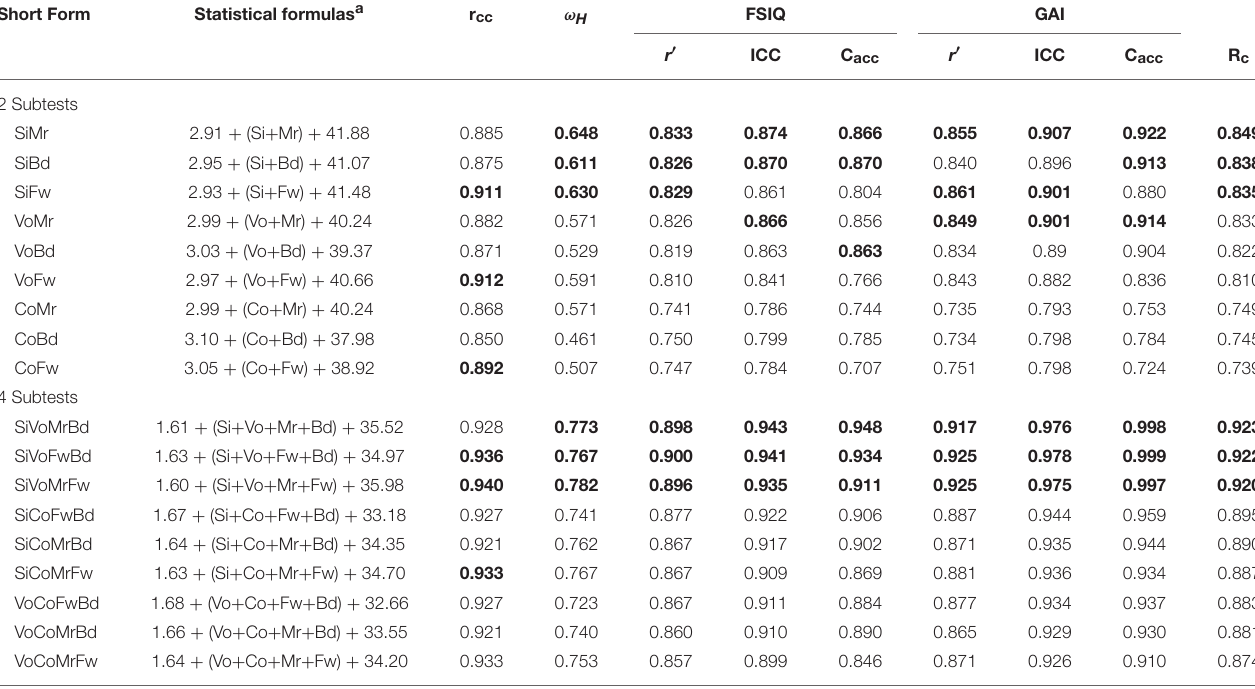
TABLE 6 | Reliability and Validity of WISC-V Short Forms from simulated data. Short